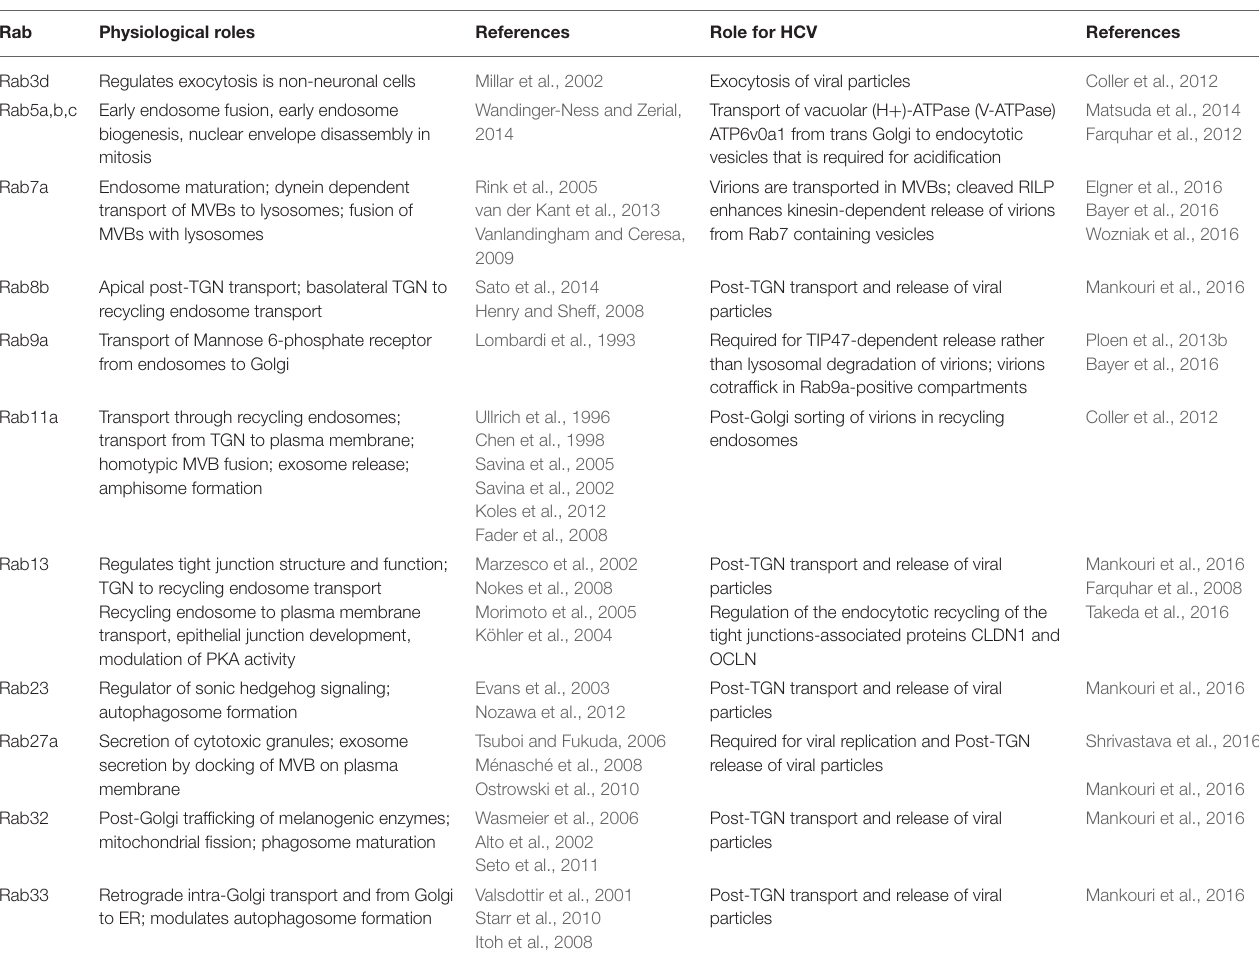
TABLE 4 | Rab proteins involved in HCV